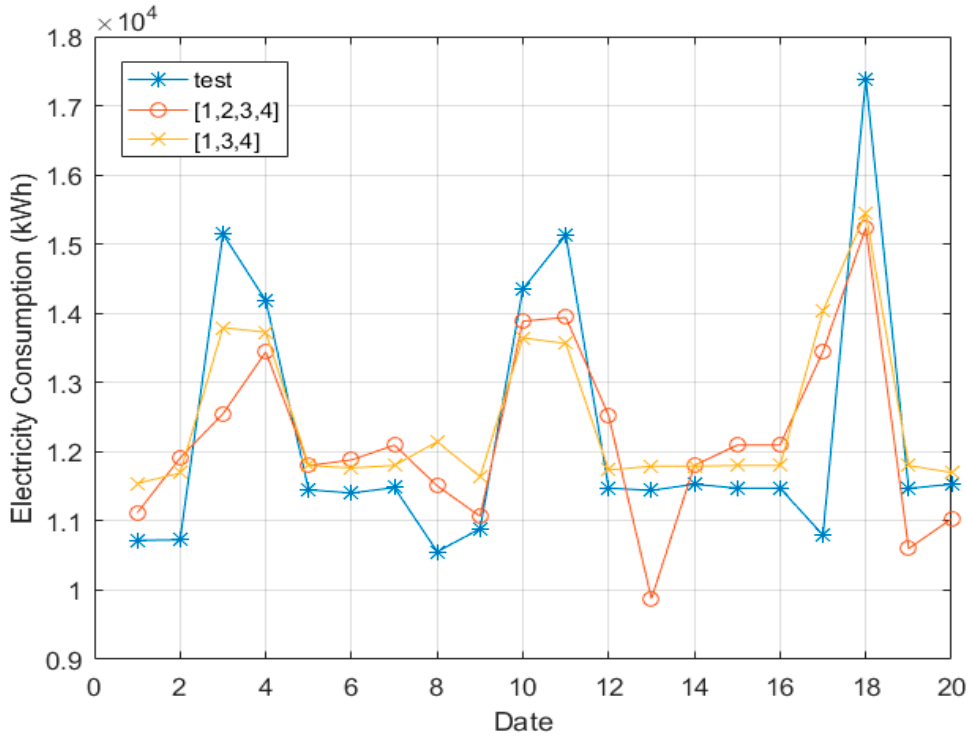
Figure 5. Test data, {1, 2, 3, 4} and {1, 3, 4} calculation with BRNN.